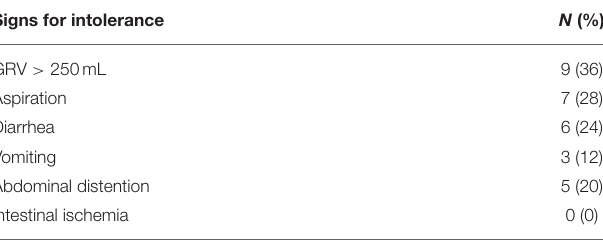
TABLE 3 | Signs for intolerance ( N = 25). Signs for